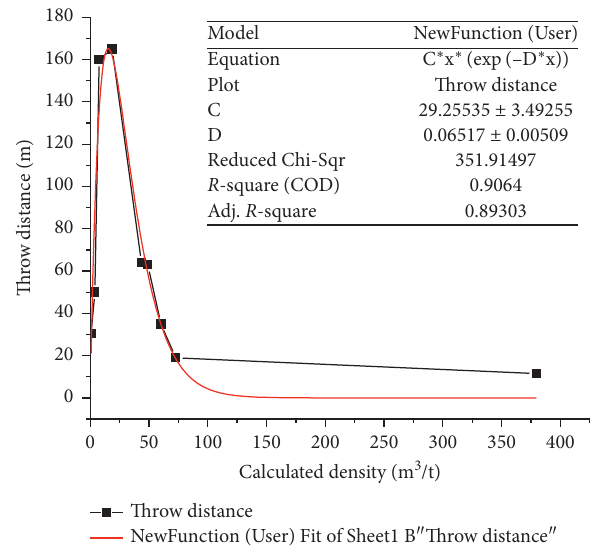
Figure 15: Origin software fitting verification.